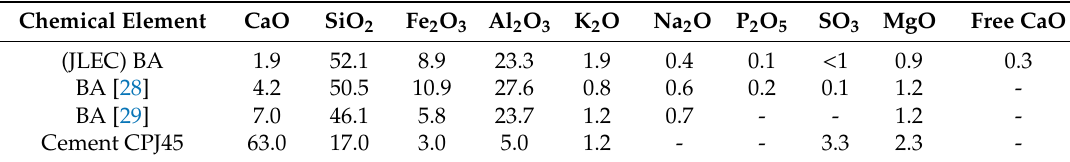
Table 3. Elemental composition (%) of bottom ash and used